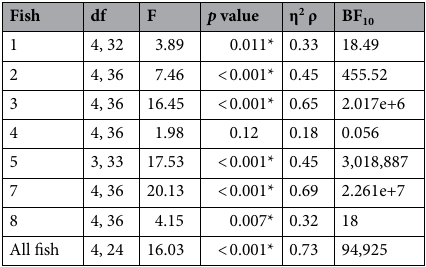
Table 3. Results of one-way ANOVA: individual level and group level. The dependent measure was the proportion of choosing the larger quantity. The independent measure was congruity level (1–5).